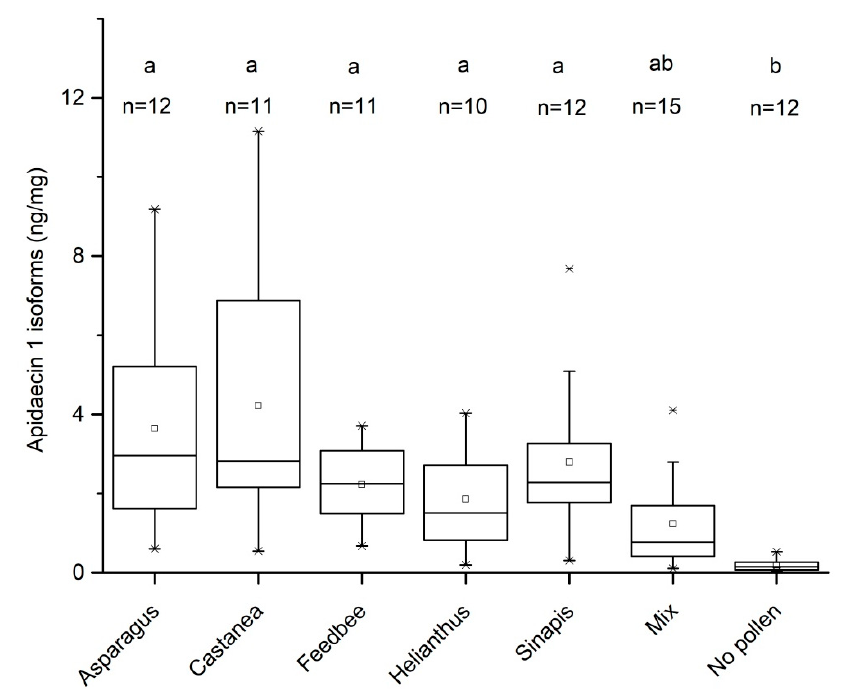
Figure 1. Concentration of apidaecin 1 isoforms in thoraces of caged bees fed different diets. Groups are labelled by small case letters; different letters denote significant differences between groups (independent-samples Kruskal-Wallis test, p < 0.05). Boxes show first and third interquartile range with line, median is denoted. Stars represent outliers, n = number of analysed individual bees, squares represent means.